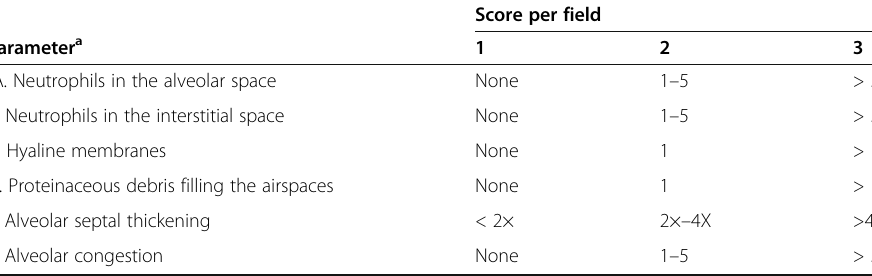
Table 1 Histologic lung injury results